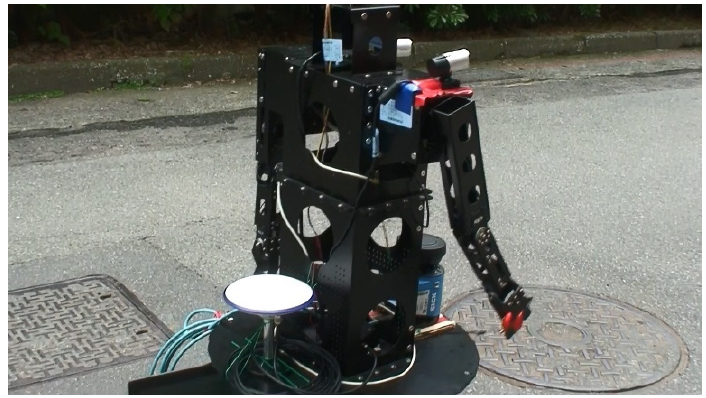
Figure 29. The robot’s arm started to activate the alarm.